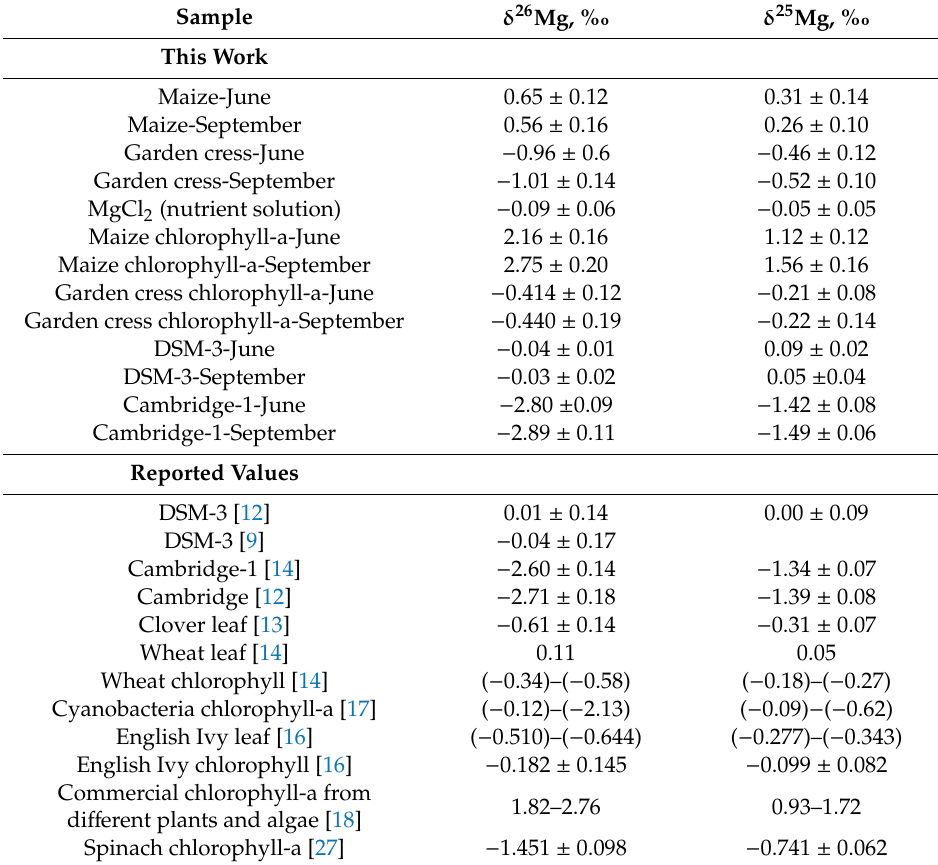
Figure 2. Magnesium–isotope ratios obtained for the samples and standards analyzed in this work; all values are expressed as permille relative to DSM-3 and were calculated using Equation (1) (Section 3.5.). Mean results are presented based on five replicates; the error bars correspond to 2SD. Linear regression fit represents the equilibrium mass-dependent fractionation line. Table 2. Magnesium–isotope ratio values obtained for the samples analyzed in this work (mean ± 2SD, based on five replicates) and selected values reported in the literature.